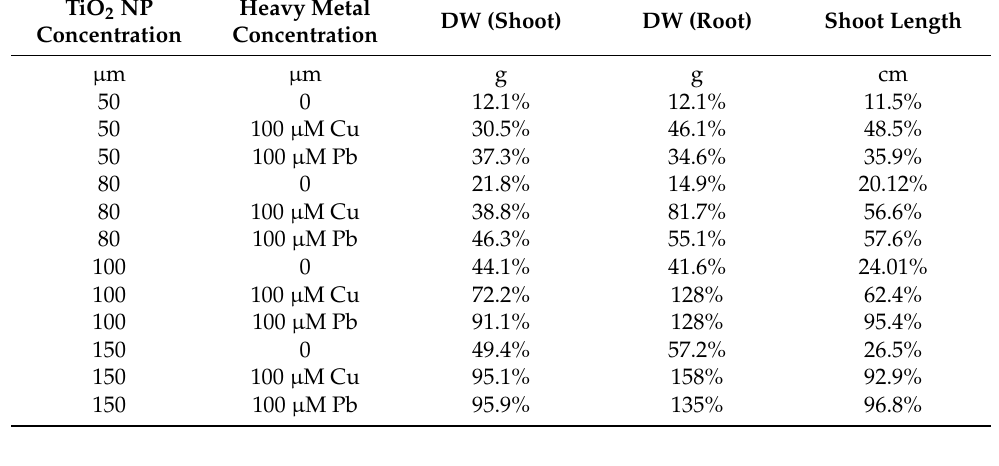
Table 4. Increase in bamboo shoot and root DW and shoot length at different concentrations of TiO 2 NPs combined with 100 µ m Cu and 100 µ m Pb compared to those of the control treatment.